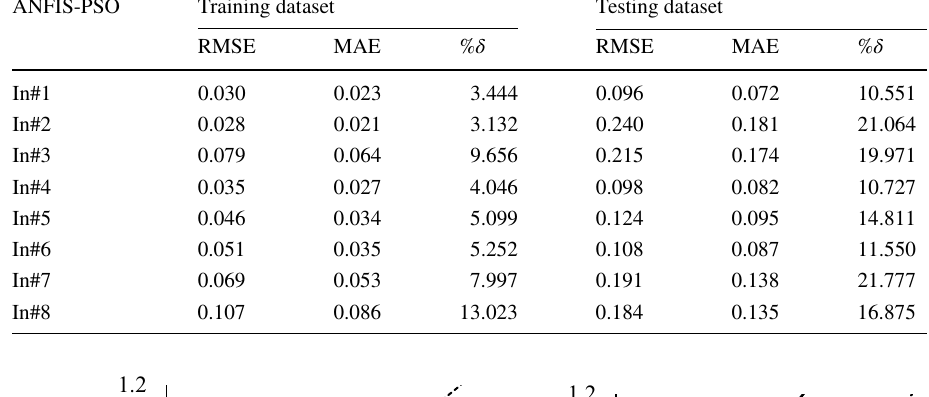
Fig. 9 Scatterplots of ANSIS- PSO for various input combina- tions